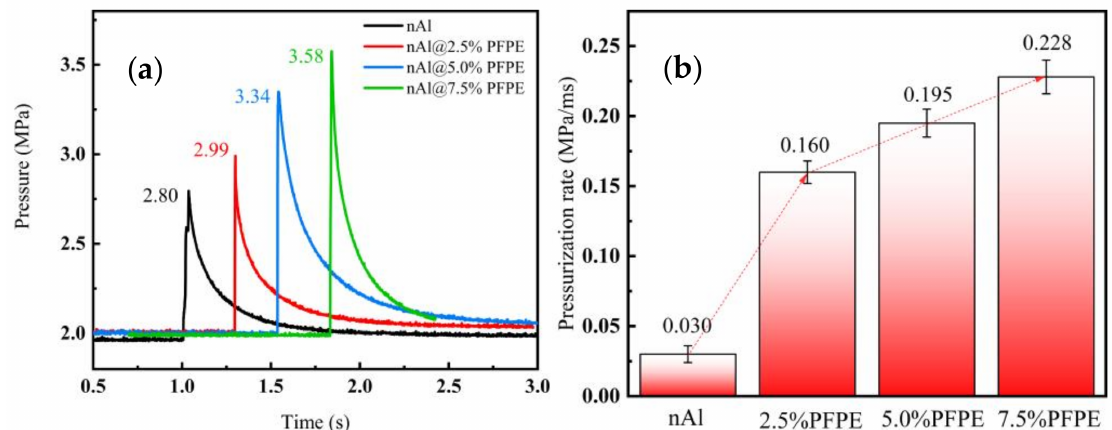
Figure 9. Comparison of ( a ) the pressure changes with time and ( b ) the pressurization rate of nAl and PFPE-functionalized Al